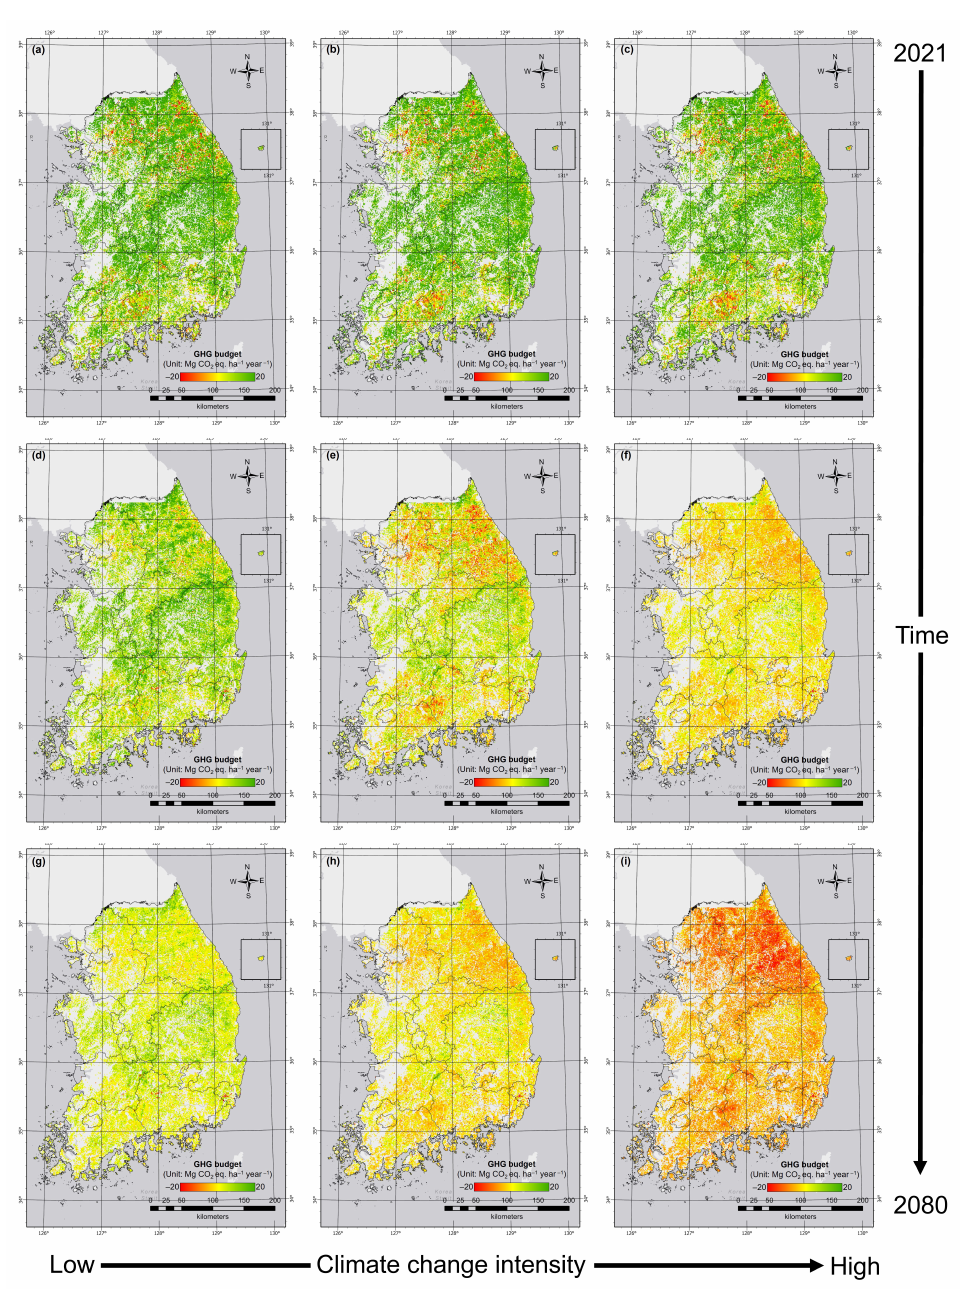
Figure 3. South Korean forest maps of GHG budget ( a – c ) in 2021, ( d – f ) in 2050, and ( g – i ) in 2080 under the current climate (left column), RCP 4.5 (center column), and RCP 8.5 (right